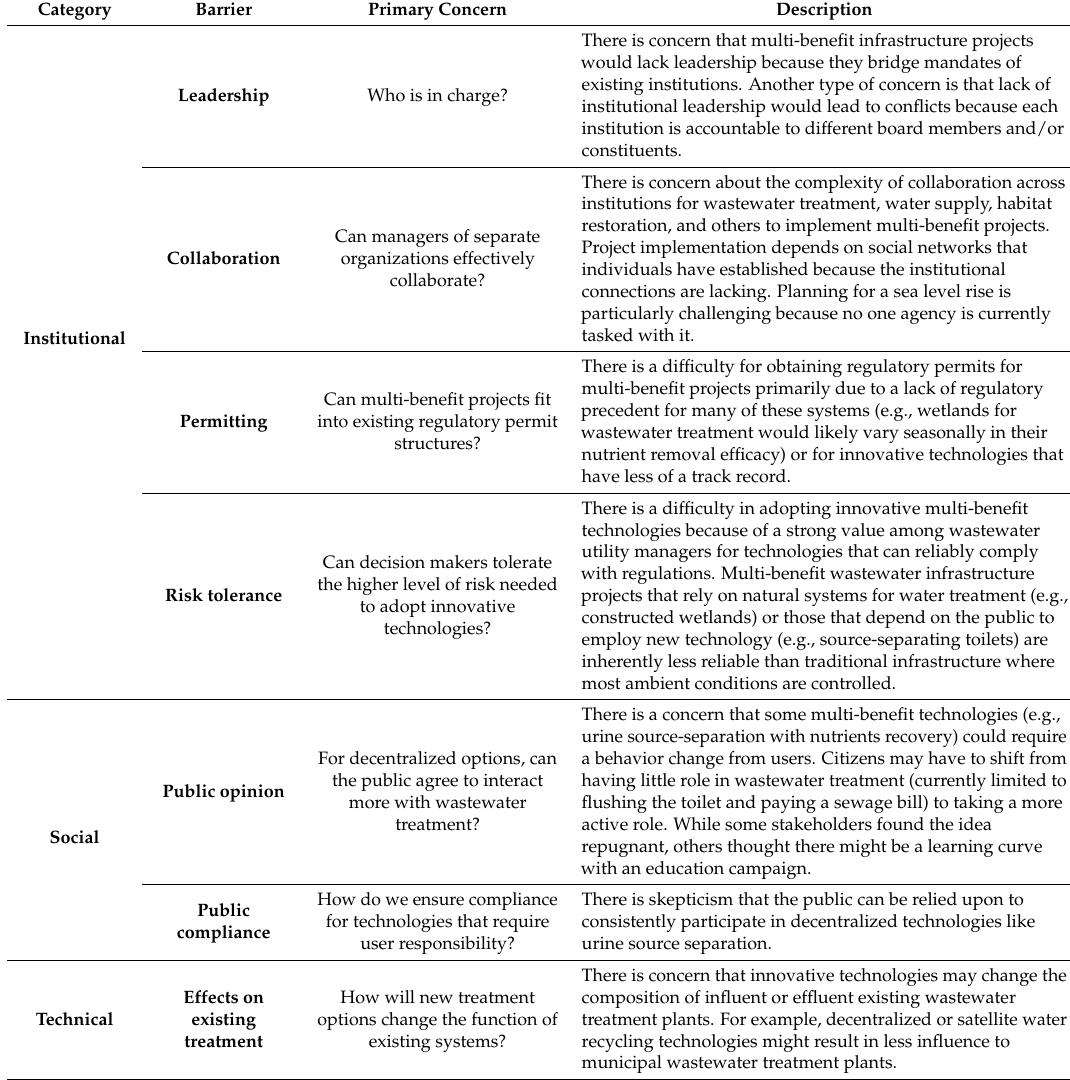
Table 3. Perceived barriers to planning and implementation of multi-benefit wastewater